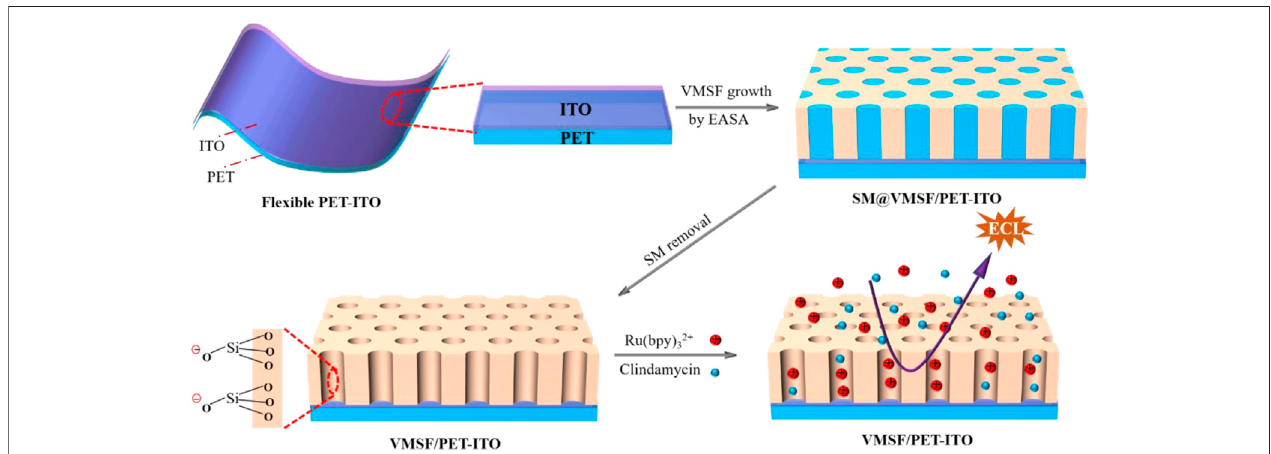
FIGURE 1 | Illustration for the preparation of VMSF/PET-ITO using the EASA method and the enrichment of Ru (bpy) 32+ on negatively charged VMSF for detection of